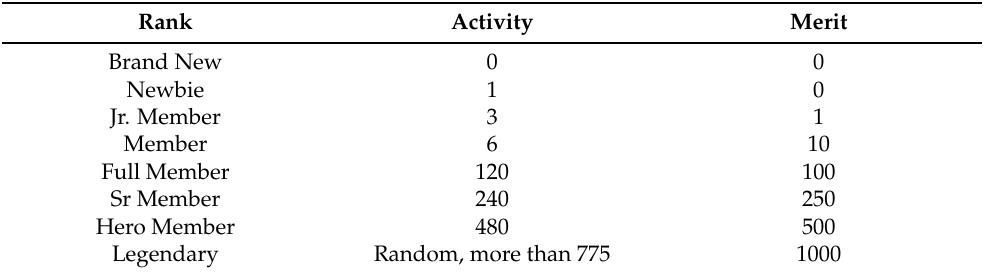
Table 2. Ranks in Bitcointalk.